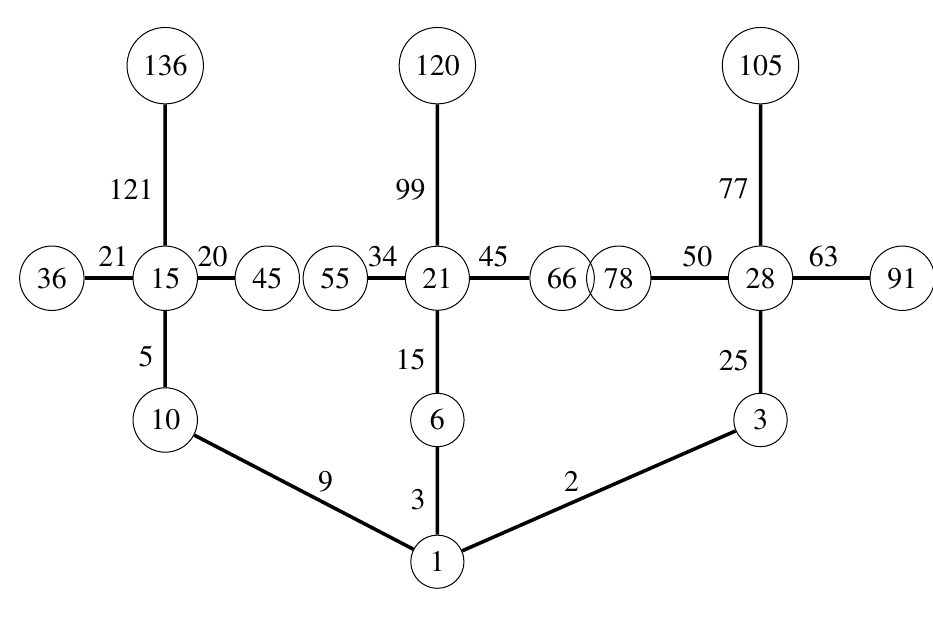
Fig.1. Range Labelling for Banana tree